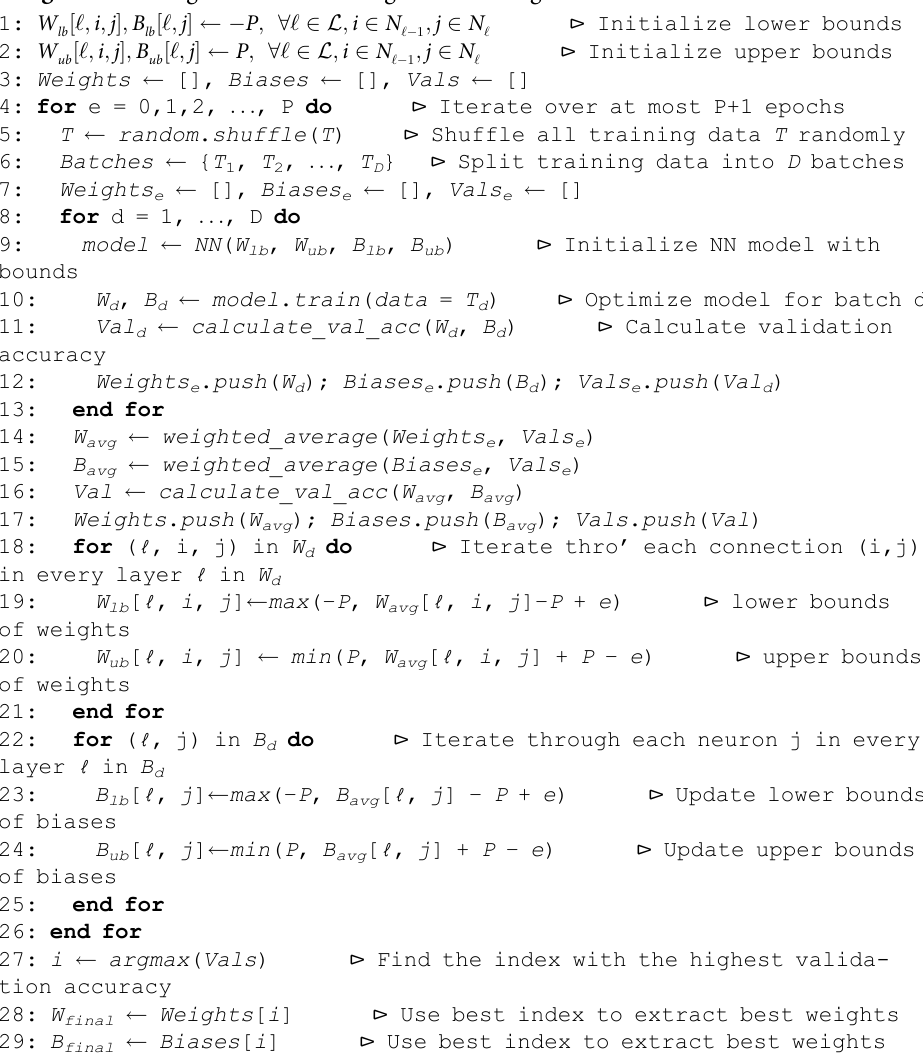
Algorithm 1 Progressive constraining batch training method for MIP